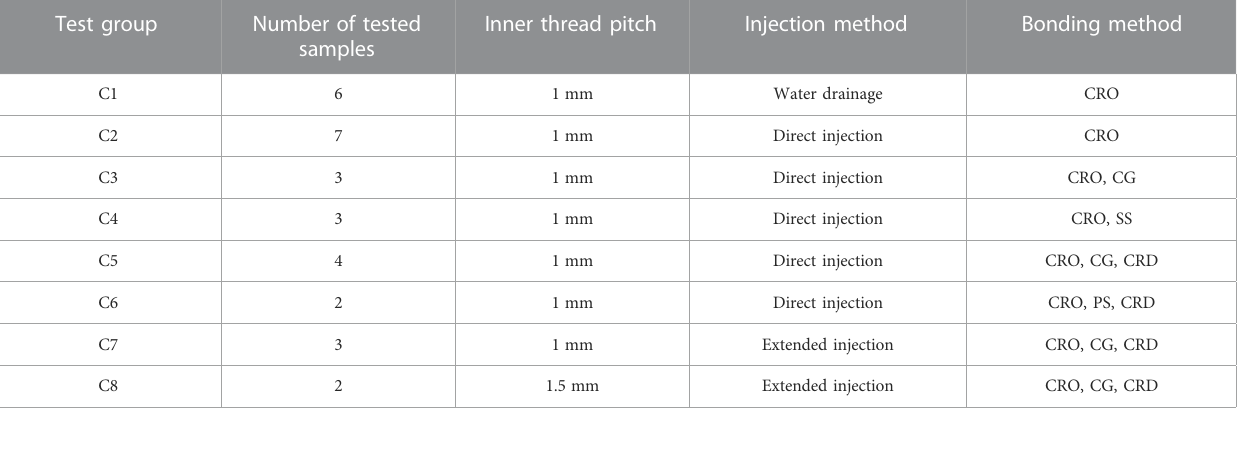
TABLE 5 UBC test parameters for the SBCAS.